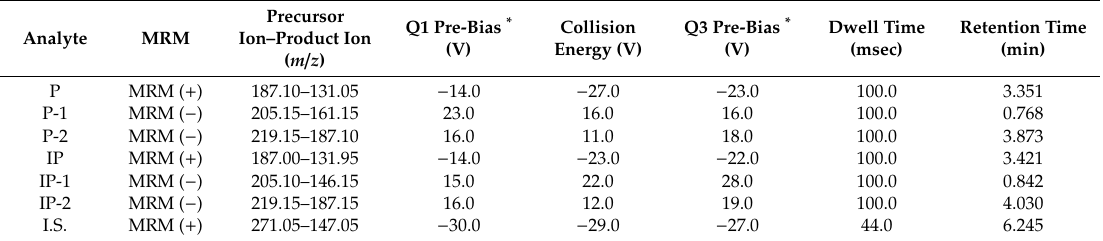
Table 1. Optimized multiple reaction monitoring (MRM) parameters of five compounds and internal standard (I.S.) in mass